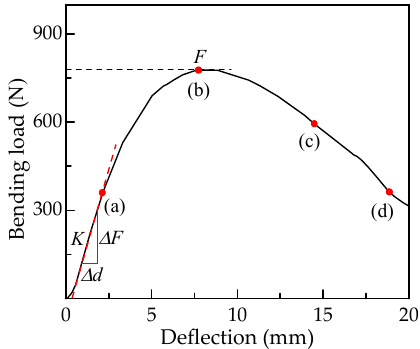
Figure 3. A typical bending load and deflection curve of the M–T joint measured 30 mm long by 15 mm wide with four critical loading points, ( a ) 364 N in linear stage, ( b ) the maximum load 778 N, ( c ) 594 N at failure stage, and ( d ) 366 N at failure stage.